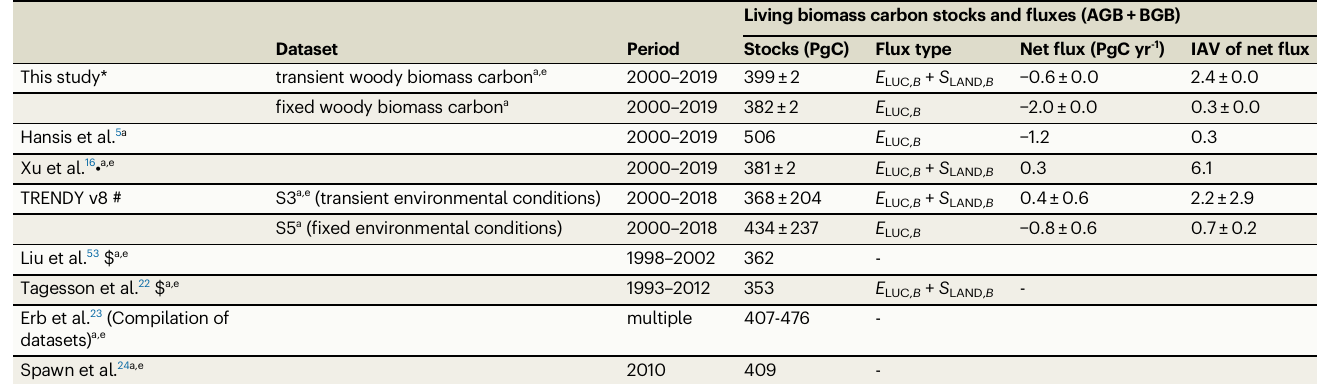
Table 1 | Comparison of global living biomass (above- plus belowground) carbon stocks and associated fl uxes (positive for uptake and negative for release) from this study compared to a range of other recent